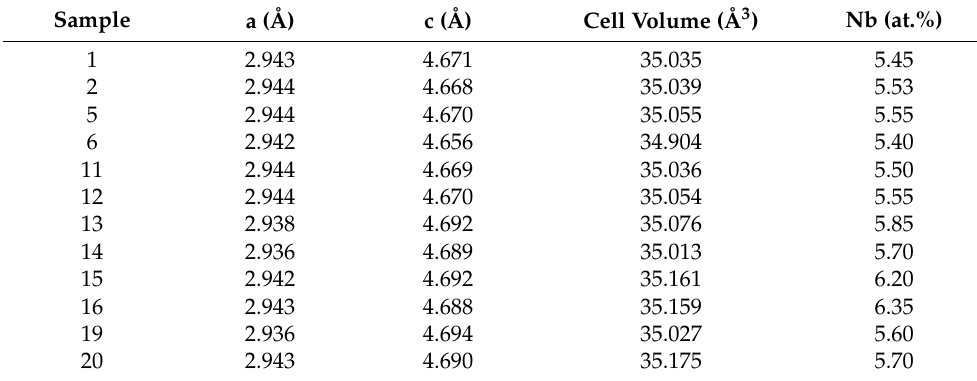
Figure 10. XRD patterns of samples of set II (grazing incidence angle). The Nb content in the alloy, calculated from peak positions, was around 6 at.% (Table 7), which is to be compared with the equilibrium value of hcp structure—that is, around 2 at.% [23,25]. Another effect of the high number of pulses at a higher applied voltage was the further decrease in the crystallite size, which diminished even more com- pared to the first set of samples. In samples of set II, crystallites reached a mean size of around 15 nm. Table 7. Lattice parameters, cell volume and Nb content in hcp of Ti–Nb alloy.